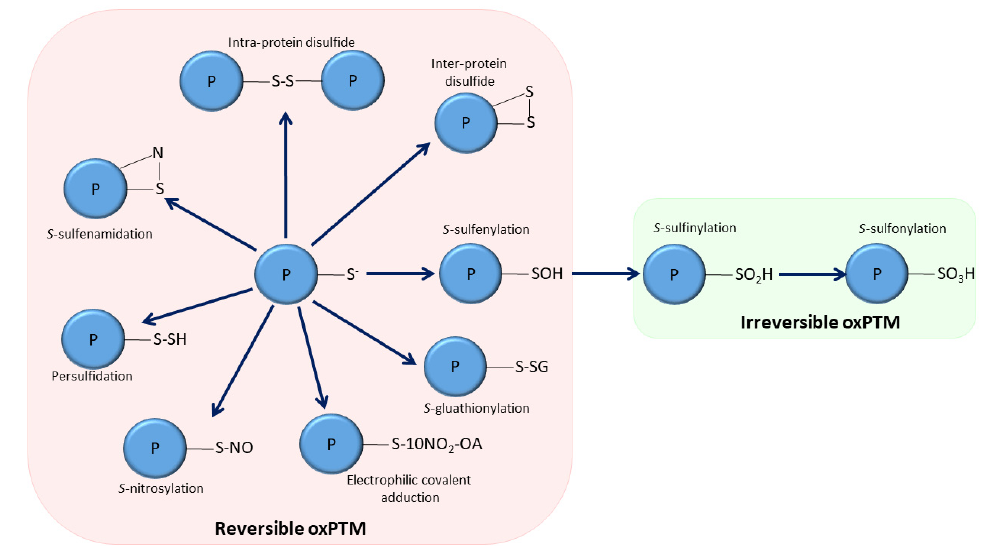
Figure 1. Summary of the oxPTMs formed in protein thiols. Thiolate anions can react with a variety of reactive oxygen or nitrogen species to form reversible (intra-protein disulfides, inter-protein disulfides, S -sulfenylation, S -nitrosylation, S -glutathionylation, persulfidation, S -sulfenamidation, electrophilic covalent adduction) and irreversible hyper-oxidized ( S -sulfinylation, S -sulfonylation) redox states.